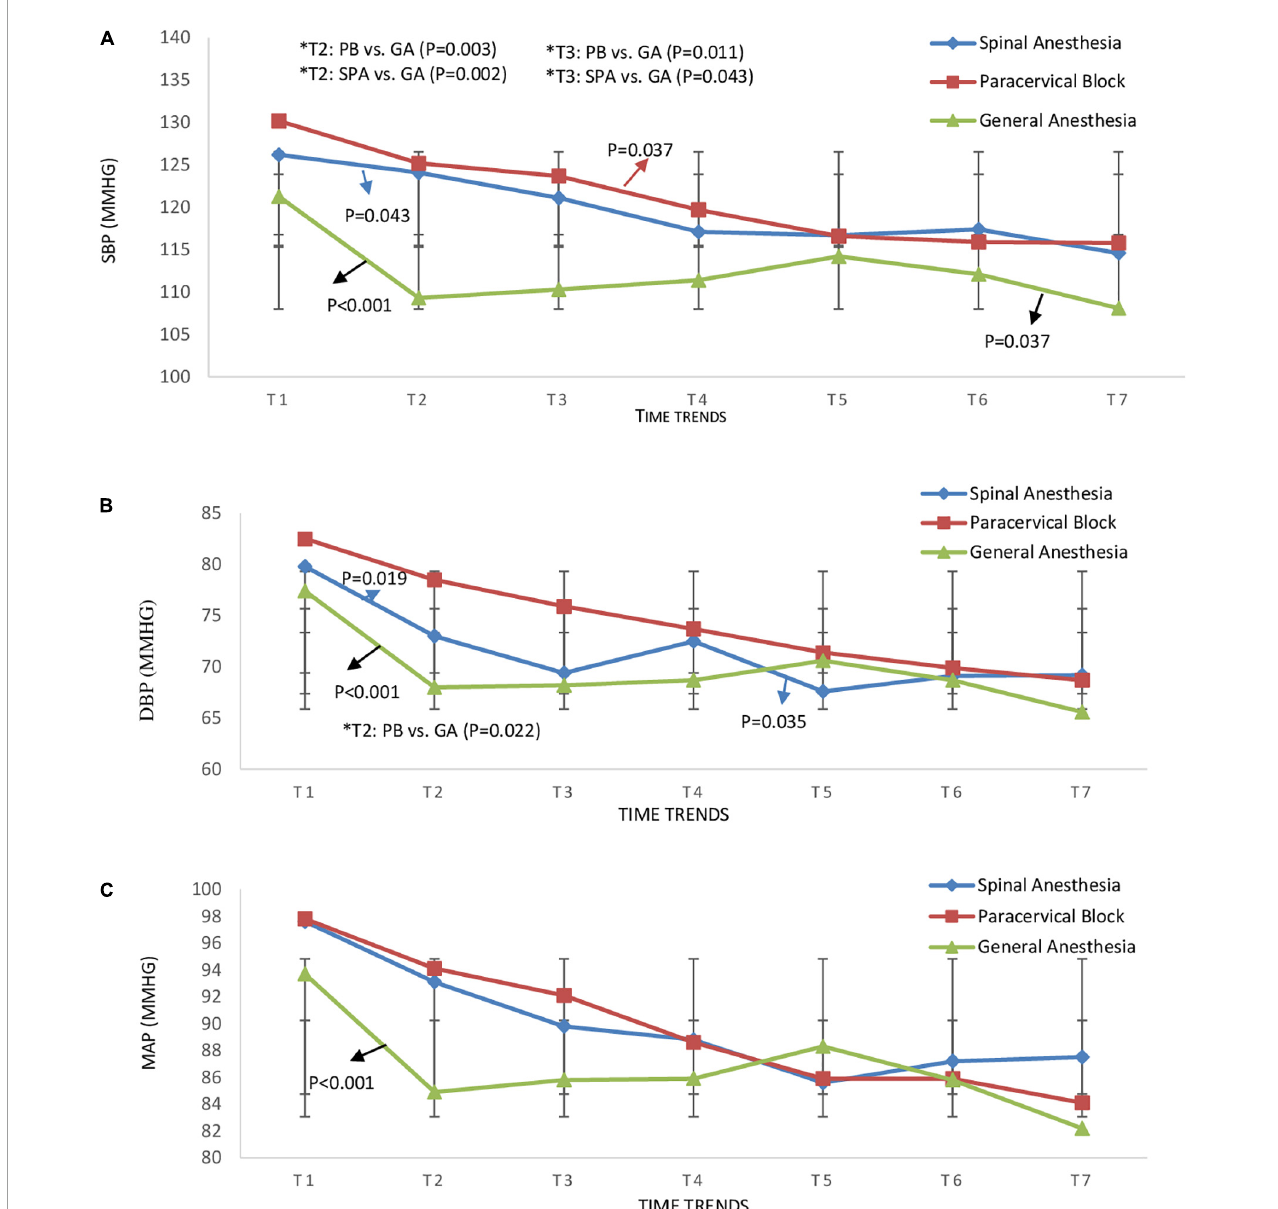
FIGURE2 Time trend changes in panel (A) systolic blood pressure (SBP) (mmHg), (B) diastolic blood pressure (DBP) (mmHg), and (C) mean arterial pressure (MAP) (mmHg) in three groups of study. Time trends as follows; T1: pre-anesthesia, T2: during-anesthesia, T3: during-tenaculum, T4: during-cervical dilation, T5: during-hysteroscopy, T6: during-biopsy, and T7: during-hysteroscopy removal. The P -value within group differences are indicated by arrows and between groups by ∗ . SPA, spinal anesthesia; PB, paracervical block; GA, general anesthesia.